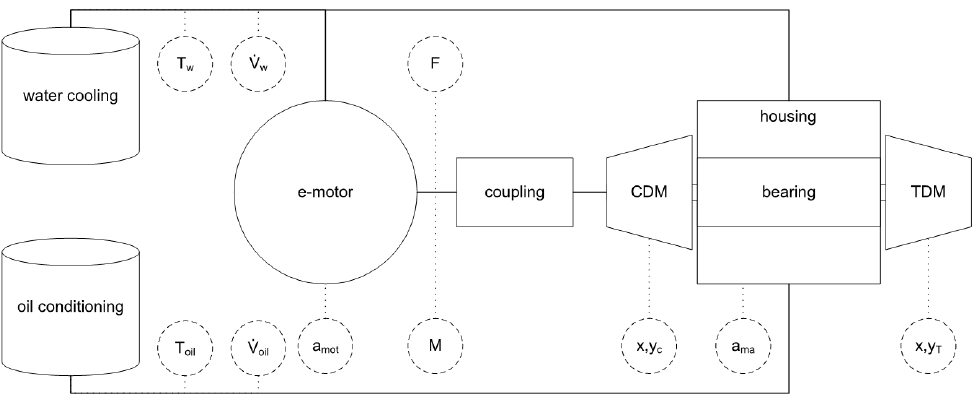
Figure 5. FTB–schematic test bed